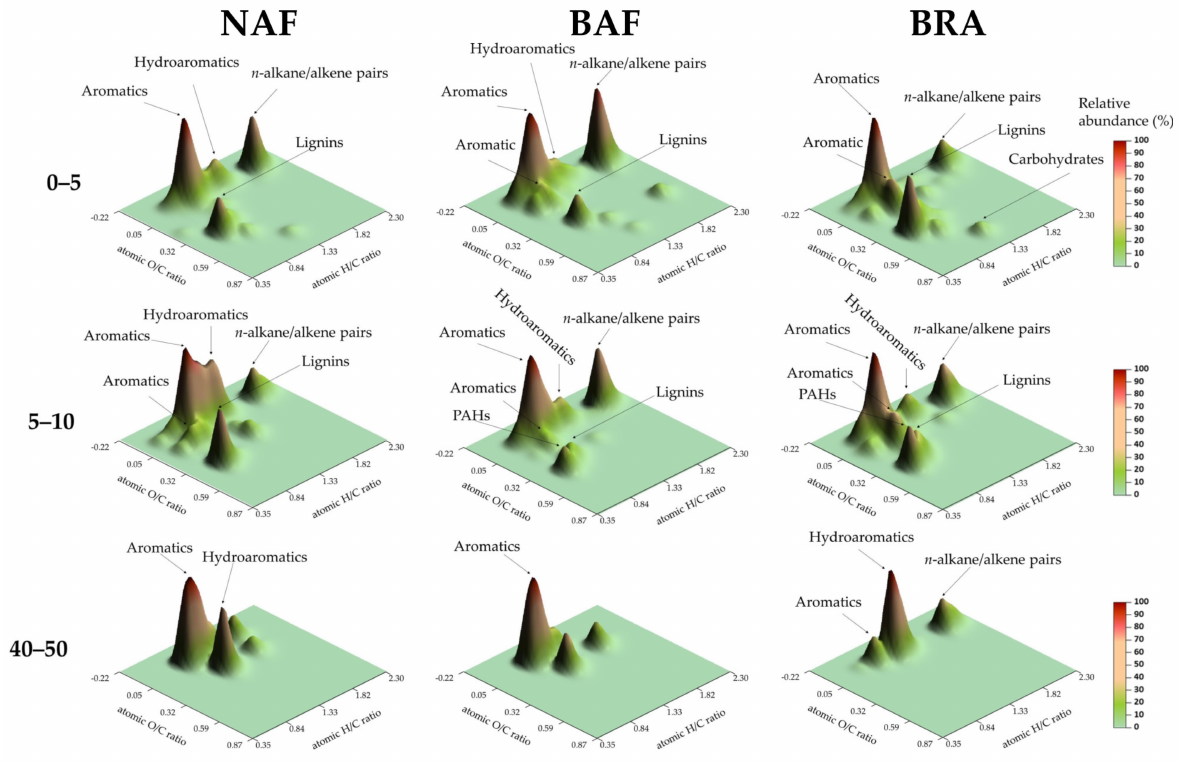
Figure 2. Surface density maps displaying cumulative abundances of Py-GC/MS products plotted in the space defined by the atomic H/C ( x ) and O/C ( y ) ratios in a van Krevelen diagram and the chromatographic yields as total abundances ( z ). Labels on the plots indicate major groups of organic compounds. Soil samples were collected at 0–5, 5–10 and 40–50 cm depth at the native Amazon Forest (NAF), burned Amazon Forest (BAF) and Brachiaria (BRA)